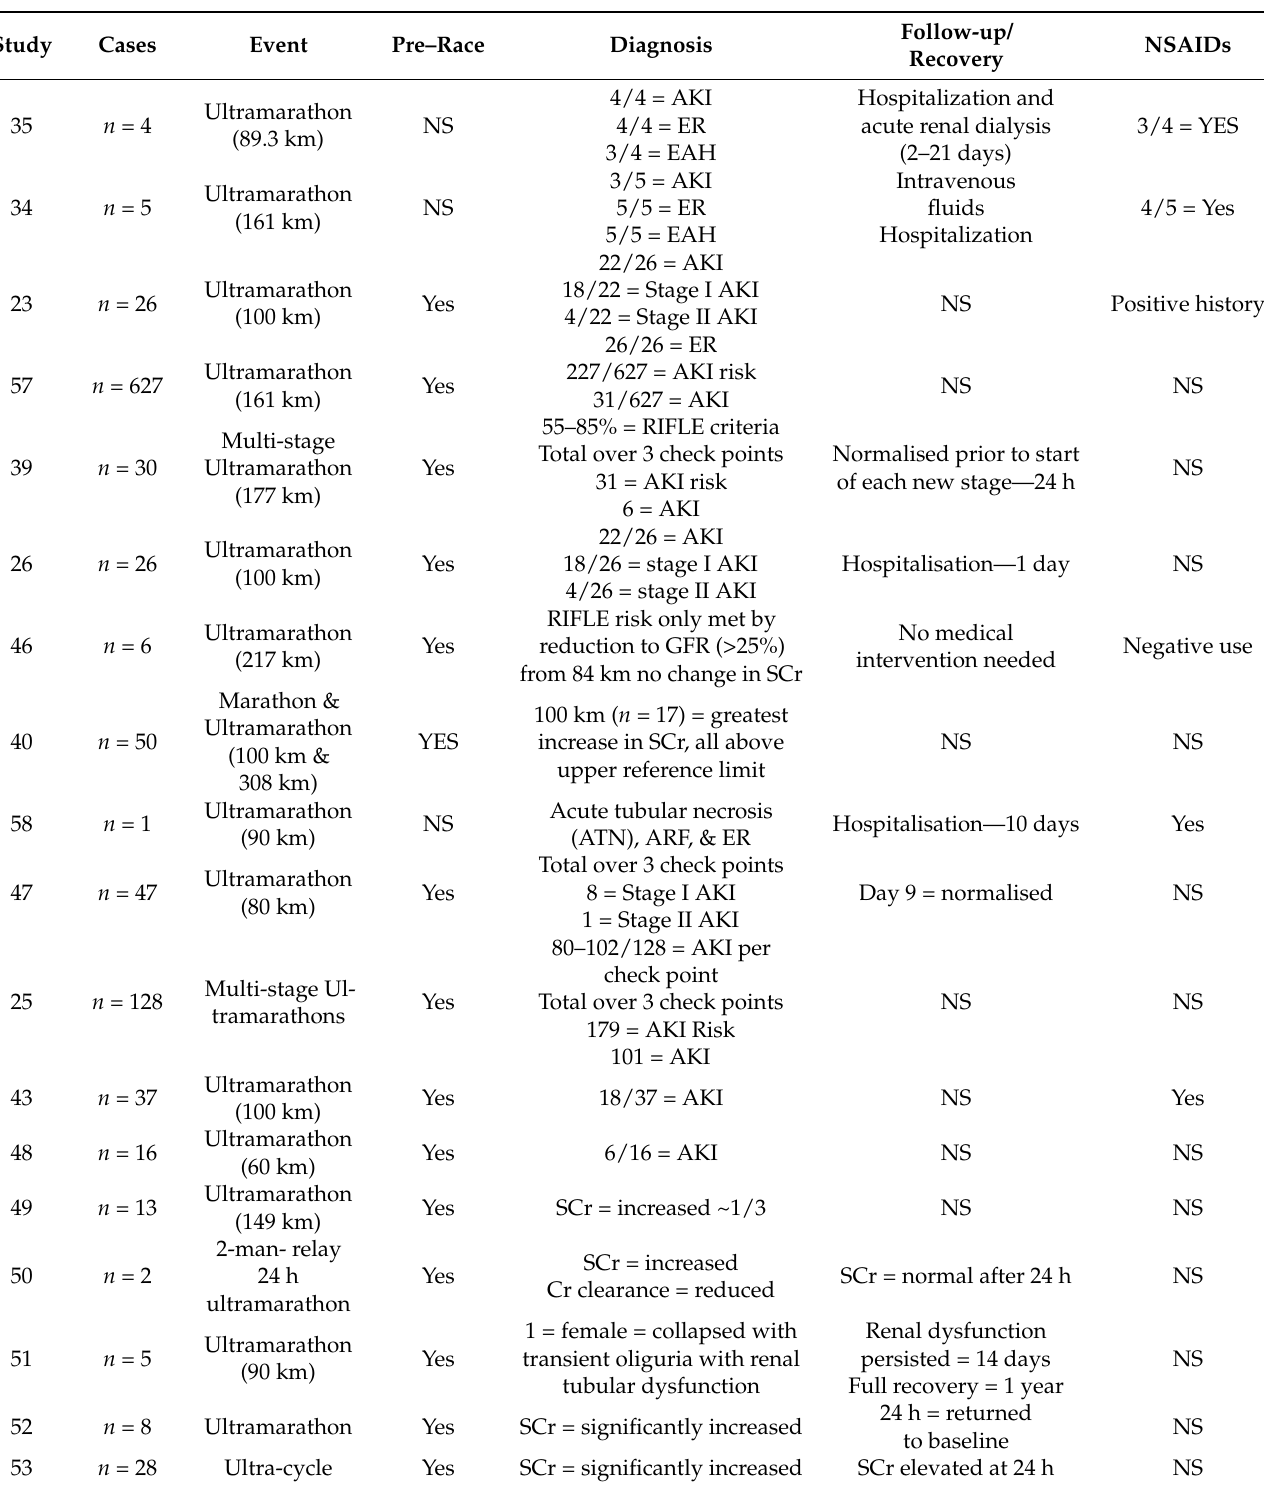
Table 1. Overview of studies examining the occurrence of AKI, Exertional rhabdomyolysis, and Exercise-associated Hyponatremia in ultra-endurance